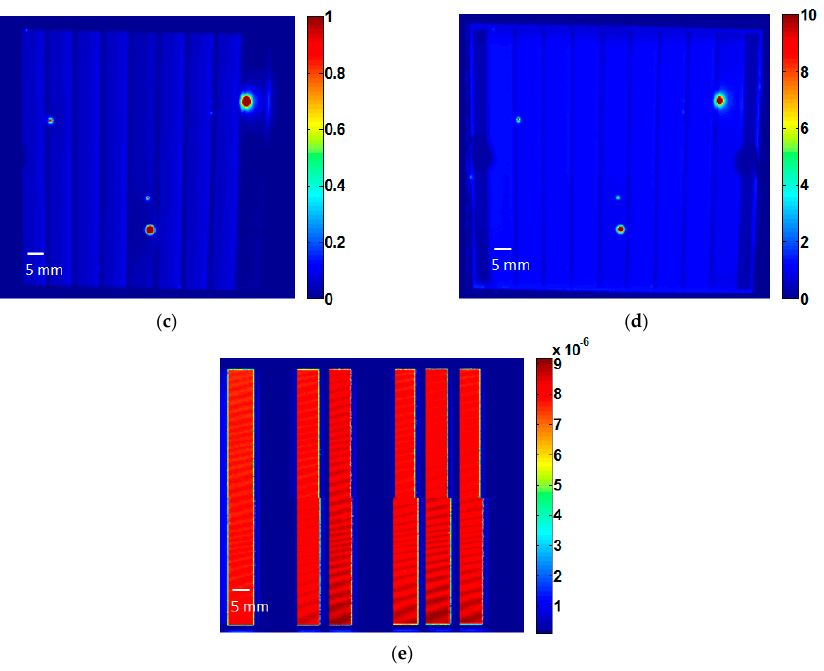
Figure 10. ( a ) EL at J sc ; ( b ) EL at one-tenth J sc ; ( c ) DLIT; ( d ) V oc -ILIT; and ( e ) li -LBIC images of TF-9 module.